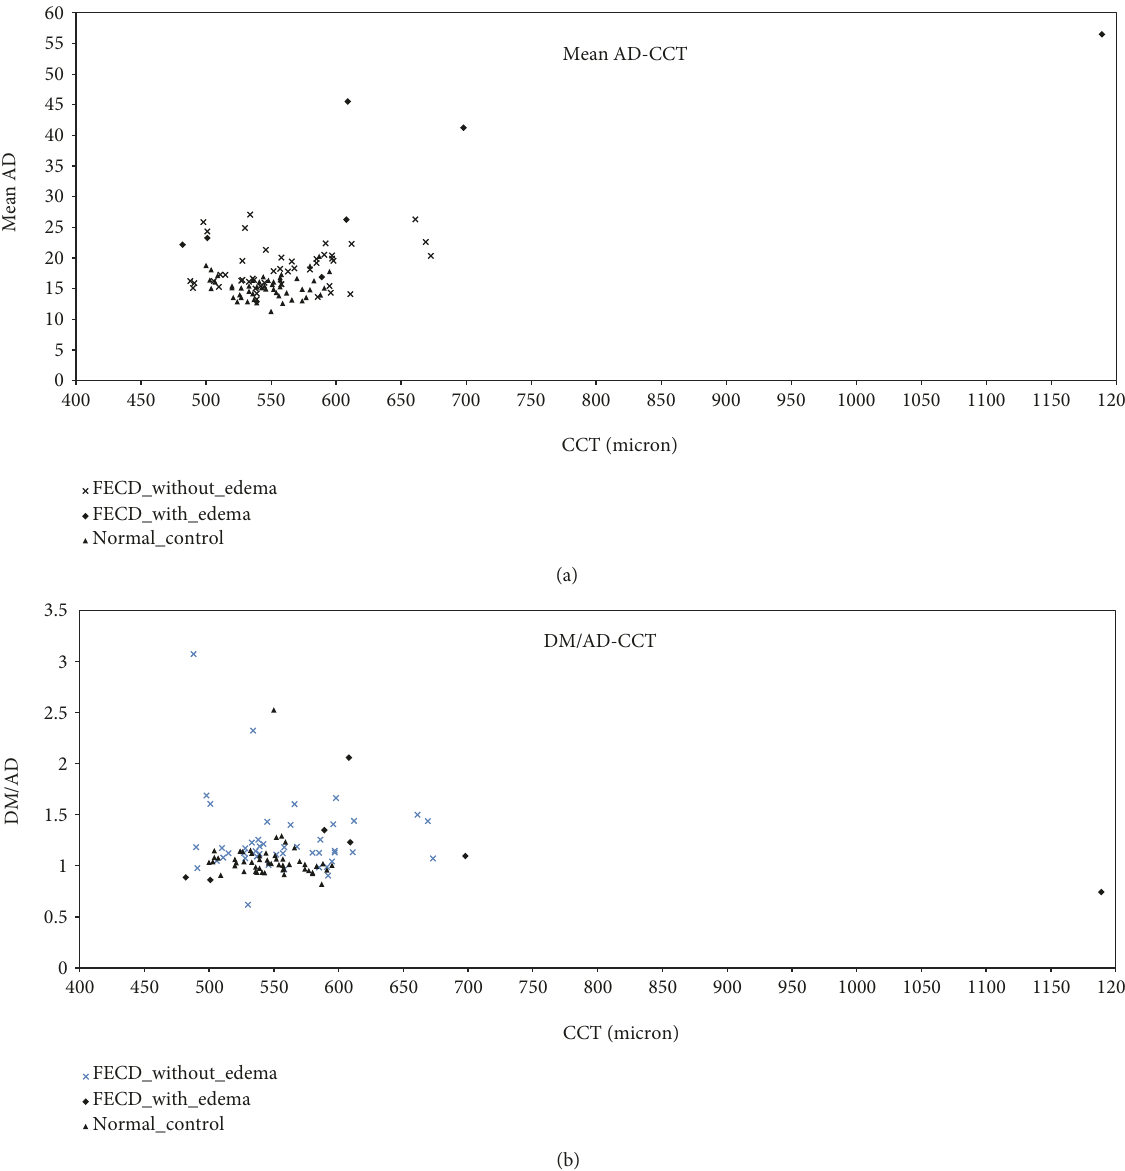
Figure 3: Scatterplots of mean area density (mean AD) against corneal thickness (CCT) (a) and average ratio of DM density versus area density (DM/AD) (b) in FECD without edema, FECD with edema, and normal